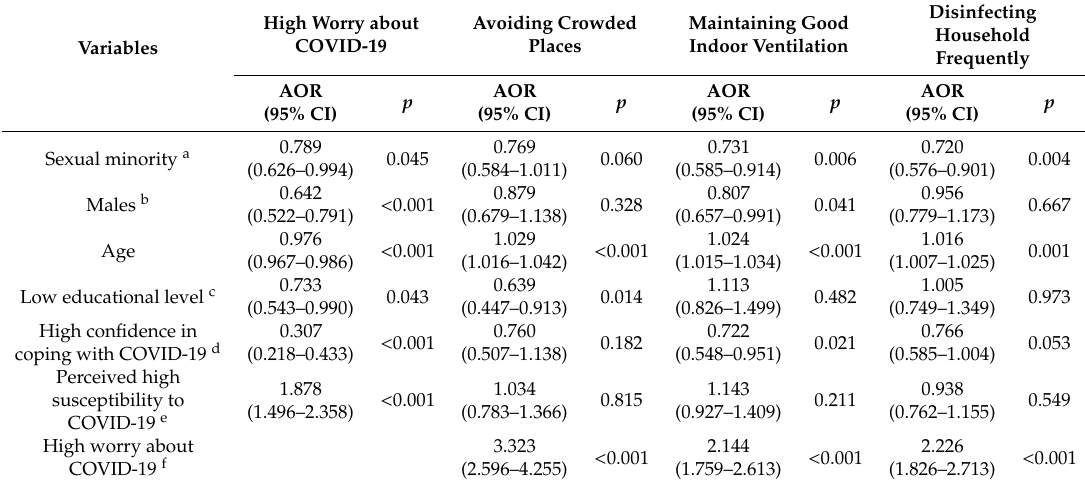
Table 3. Factors related to a ff ective and behavioral constructs of COVID-19